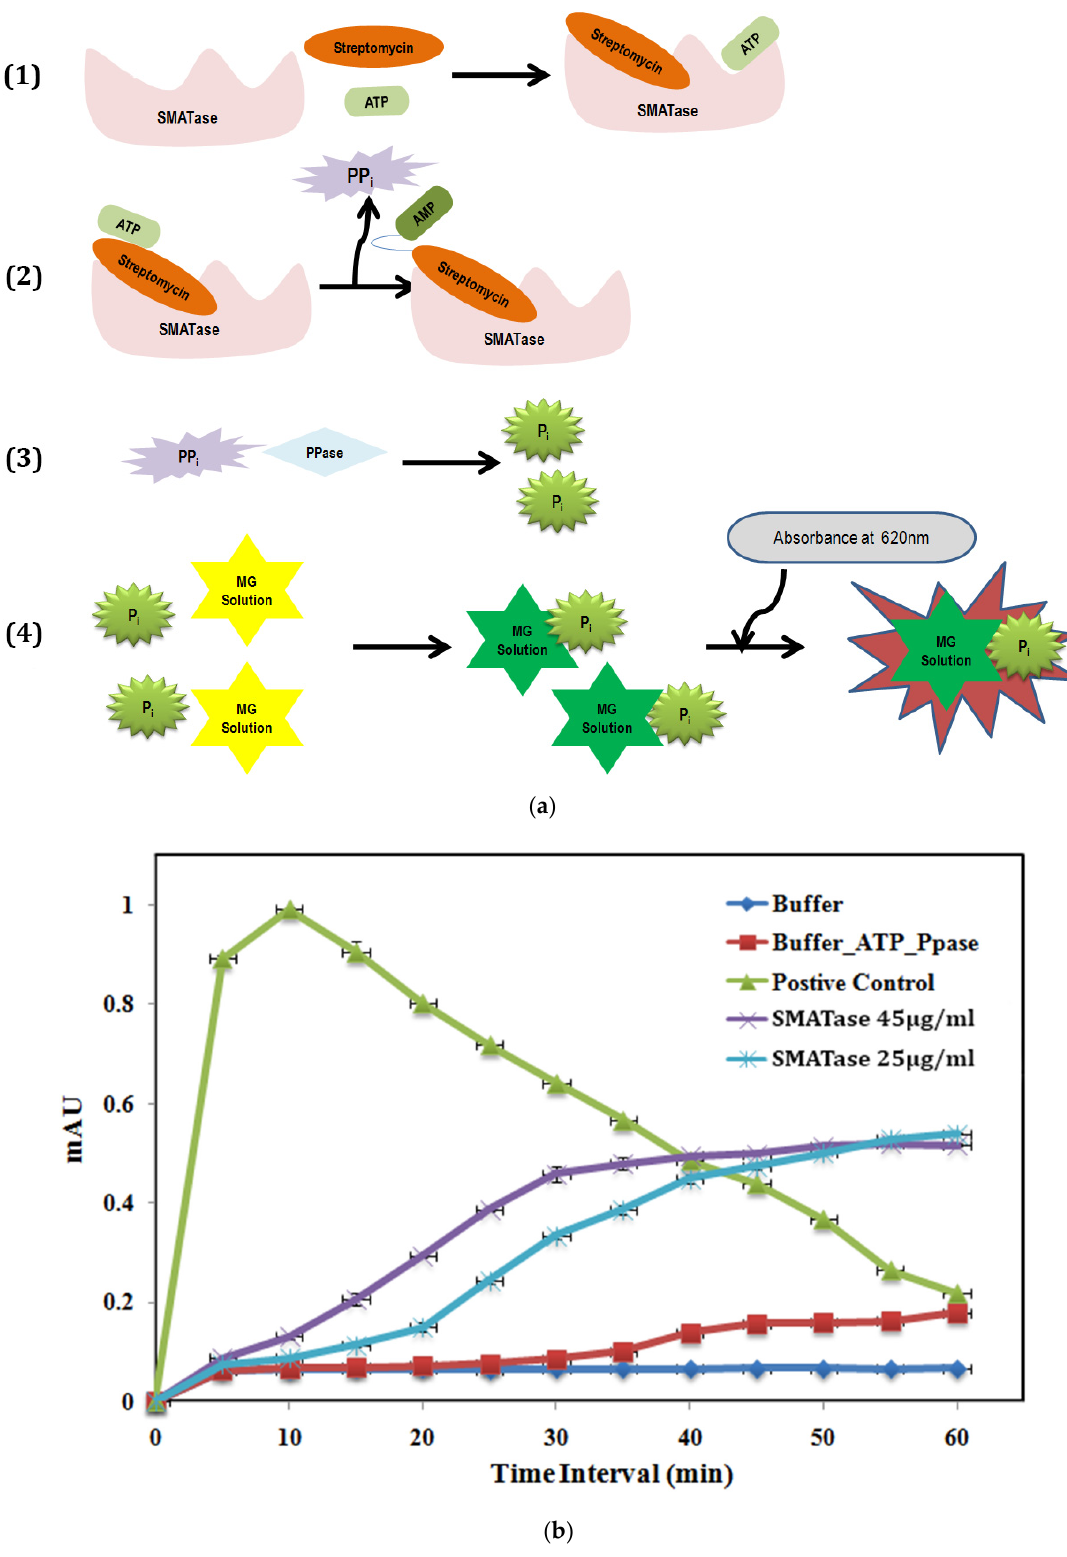
Figure 2. ( a ) Schematic stepwise working principle of malachite green adenylation assay. ( b ) Mala- chite green adenylation assay: detection of free phosphate liberated from the adenylation process is captured by malachite green solution at 620 nm. Standard phosphate of 0.5 M was used as positive control, and two different concentrations of enzymes (45 µg/mL and 25 µg/mL) were used to deter- mine the enzyme.